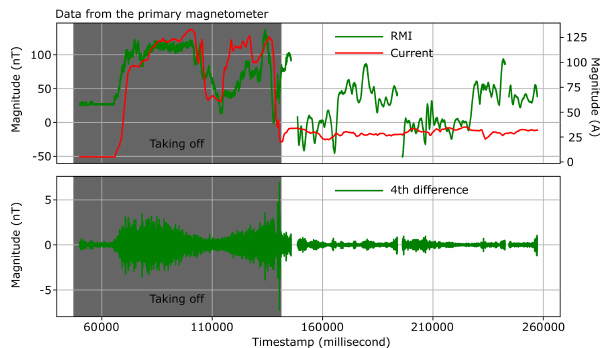
Figure 14. The production flight of the data excerpt shown in Figs. 12 and 13. The altitude indicates the in-flight height above mean sea level.